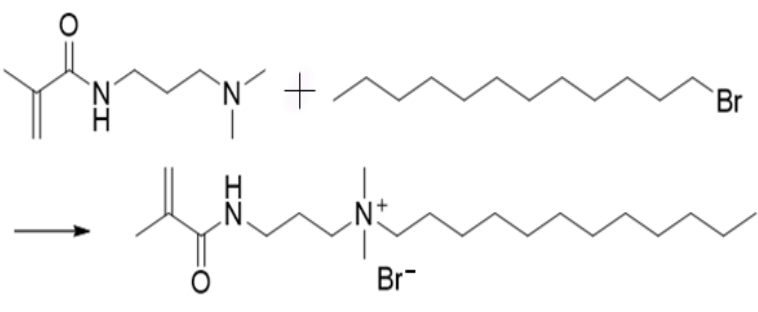
Figure 3. Synthetic route followed to synthesize CHM.